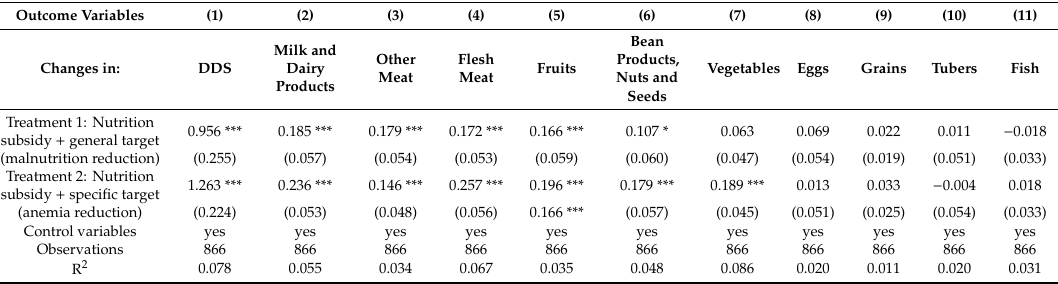
Table 4. Estimated impacts of treatments on students’ dietary